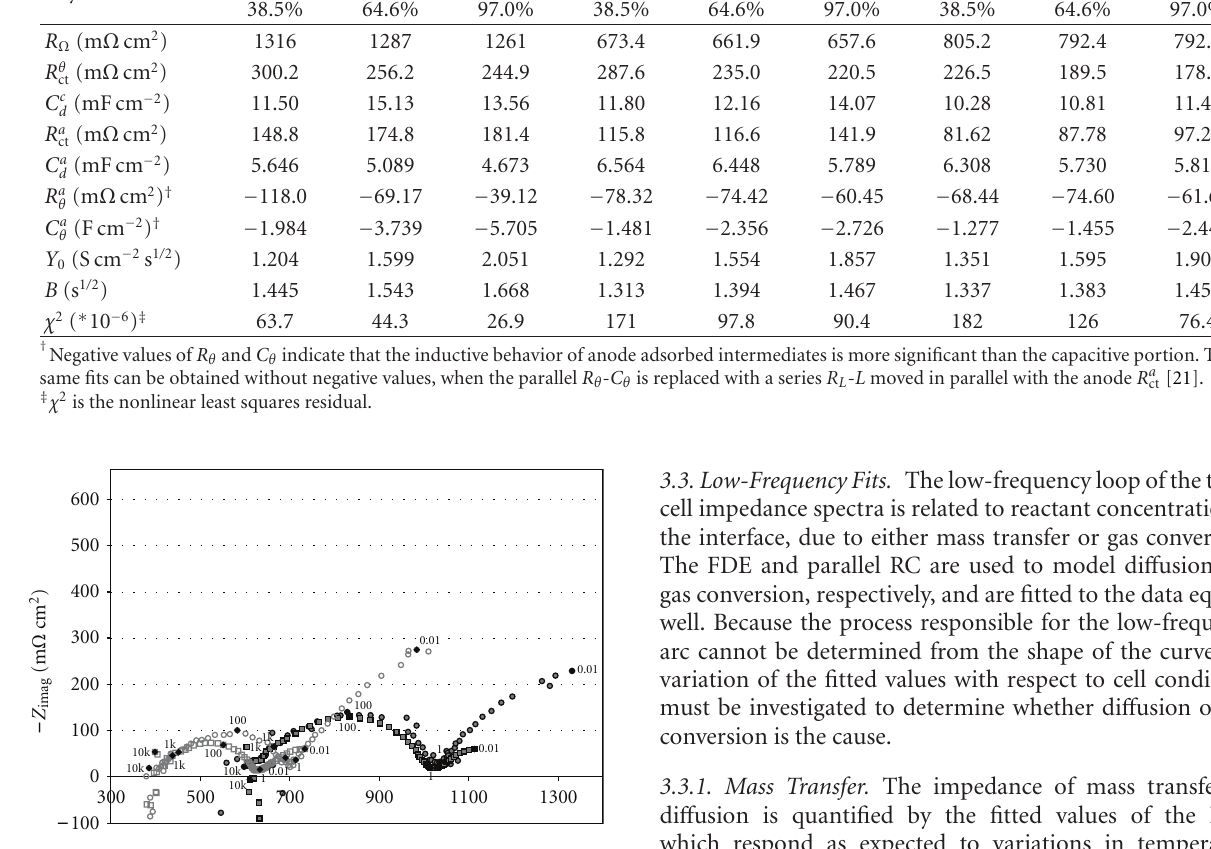
Table 2: Fitted equivalent circuit elements using the circuit model as shown in Figure 6, varying anode fuel feeds for three individual cells in a five-cell stack, and operating at 800 ◦ C, 52.46 mAcm − 2 . Feeds were 38.5 ∼ 97.0% H 2 , 3.0% H 2 O, and balance N 2 .